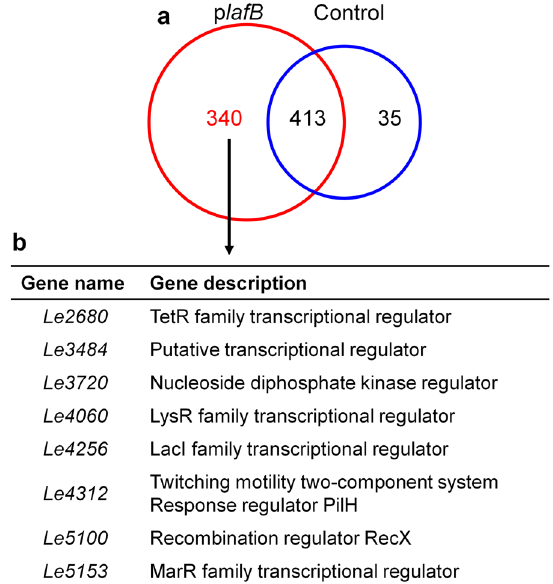
Fig. 1 DNA pull-down screen to identify potential transcription factors the regulate HSAF biosynthesis. a The Venn diagrams show the potential lafB promoter-binding proteins in the total protein extracts that were pulled down using the 5-biotinylated probe. b Eight potential transcription factors were identified that might regulate HSAF